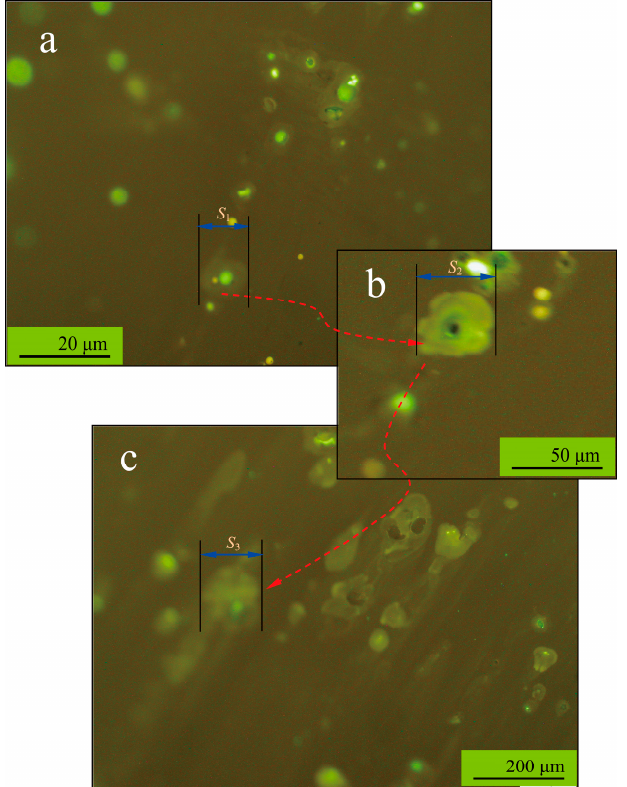
Figure 6. Fluorescence microscope morphologies of microencapsulated rejuvenator diffusing into bitumen under 25 °C at different time, the diffusion diameters of rejuvenator from one microcapsule: ( a ) S 1 at 30 min; ( b ) S 2 at 60 min, and ( c ) S 3 at 90 min.